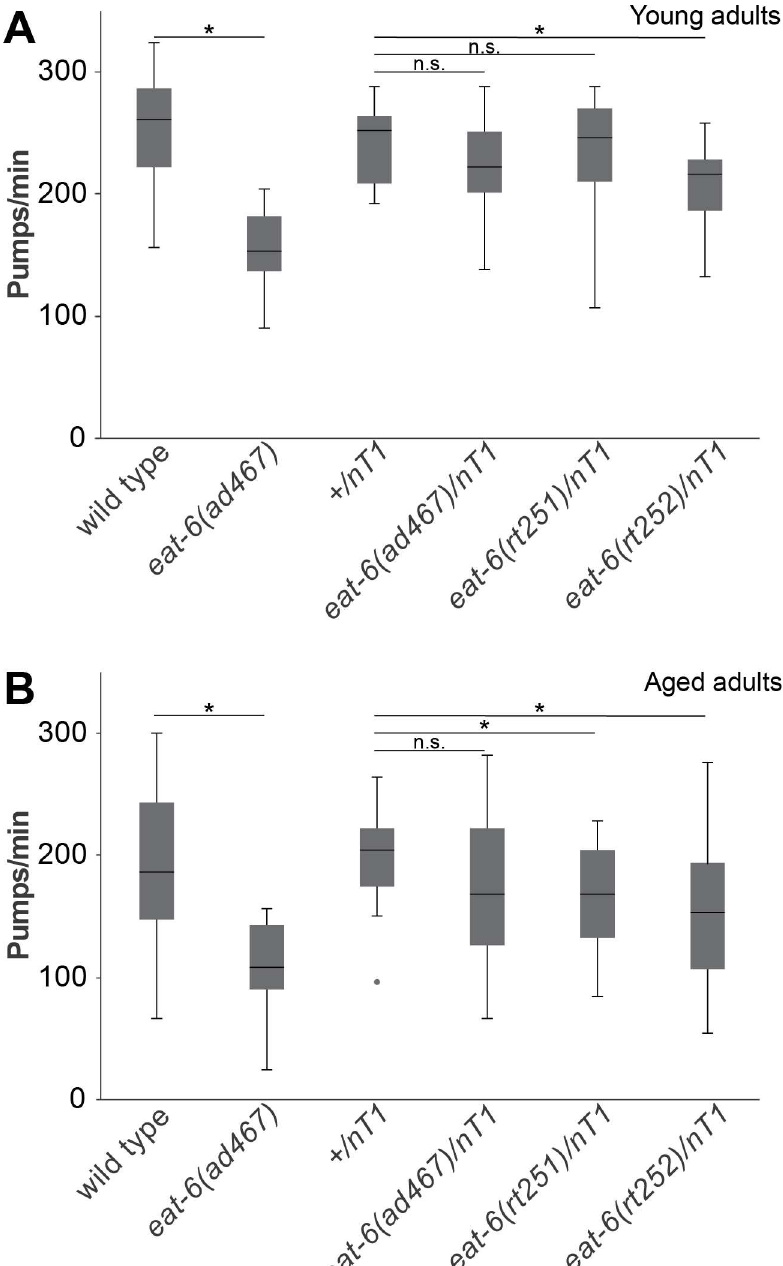
Fig 3. The dominant negative effectsof G304S increaseover time. (A) eat-6(rt252) heterozygous animals had decreased pumpingrates as youngadults. Pumpingdefects caused by ad467 were recessive. However, (B) both eat-6(rt251) and eat-6(rt252) mutants had reducedpumpingrates when aged to 8 days of adulthood (median, flanking quartilesin Tukey format; 3 trials, * : Mann-Whitney U-test (two-tailed) p-value < 0.05; n.s.: not significant,p-value >